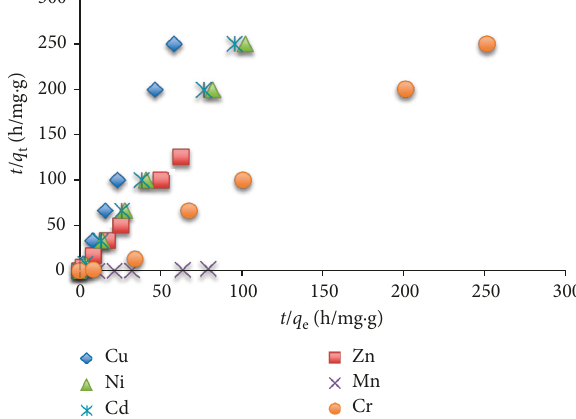
Figure 6: Pseudo-second order kinetics for the uptake of heavy metals from water.